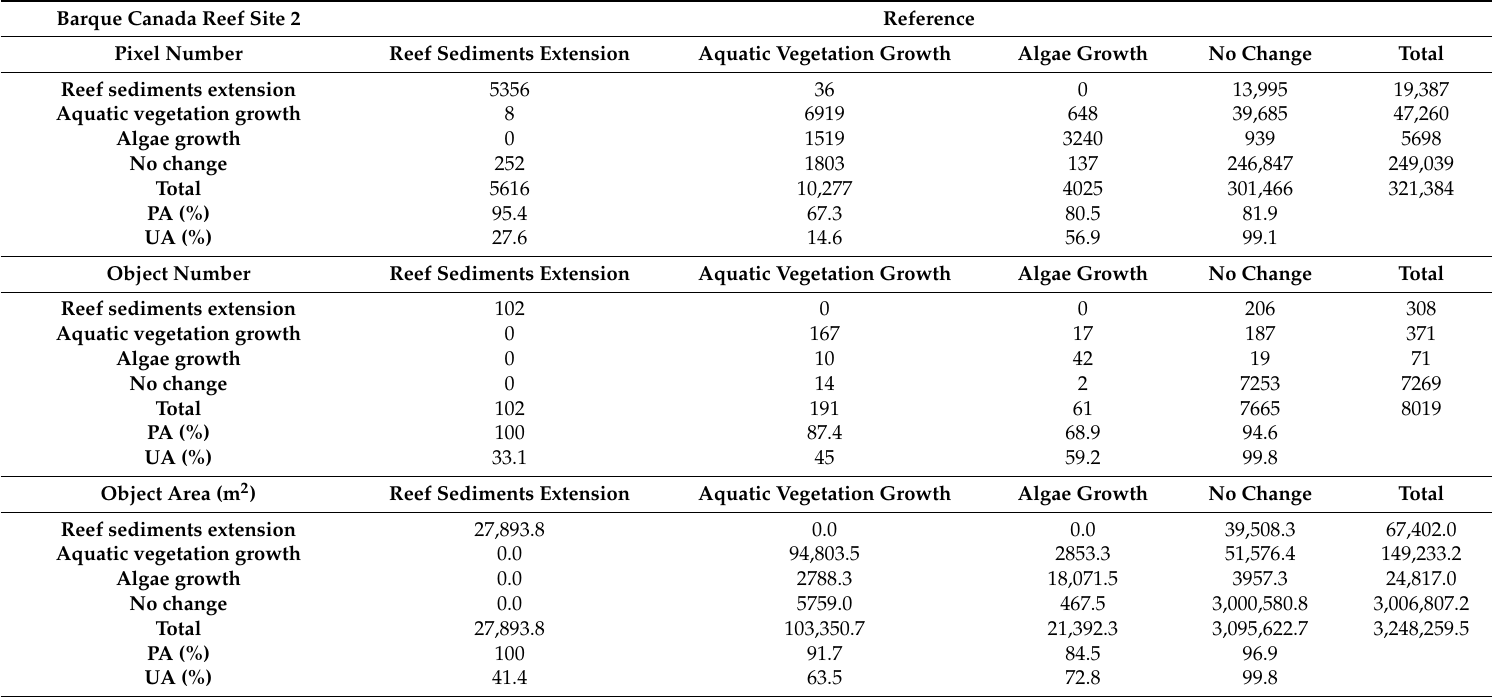
Table 7. Confusion matrices of PBCD and OBCD results for Barque Canada Reef Site